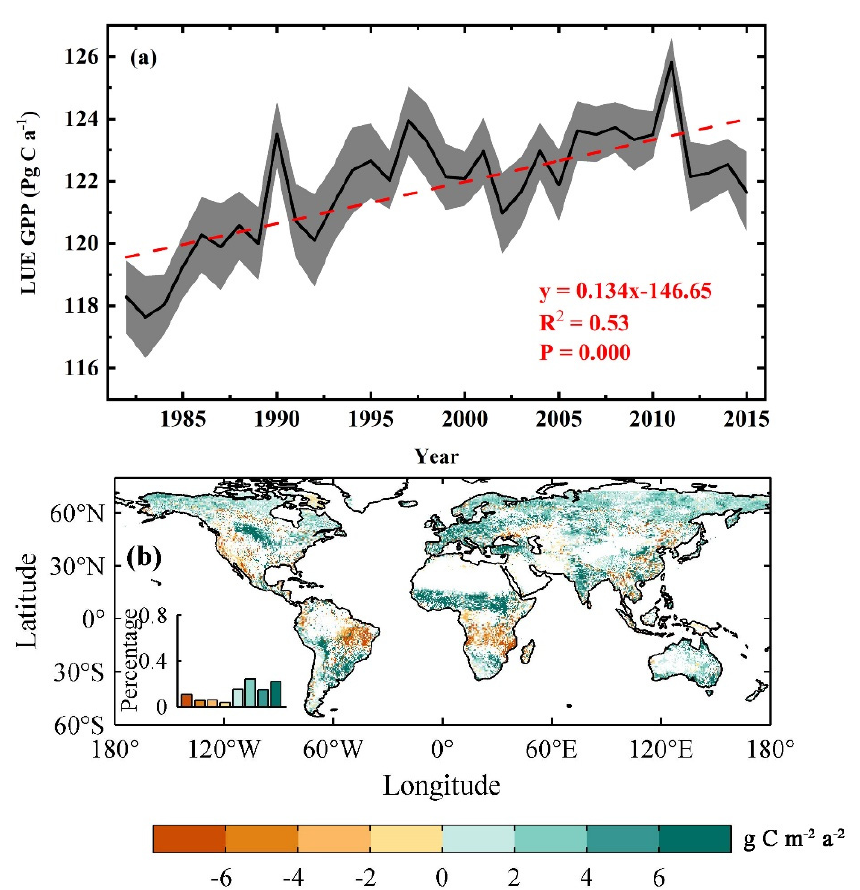
Table 1. Regression statistics for different light-use efficiency models between each land-use type’s measured FLUXNET GPP and LUE GPPs.